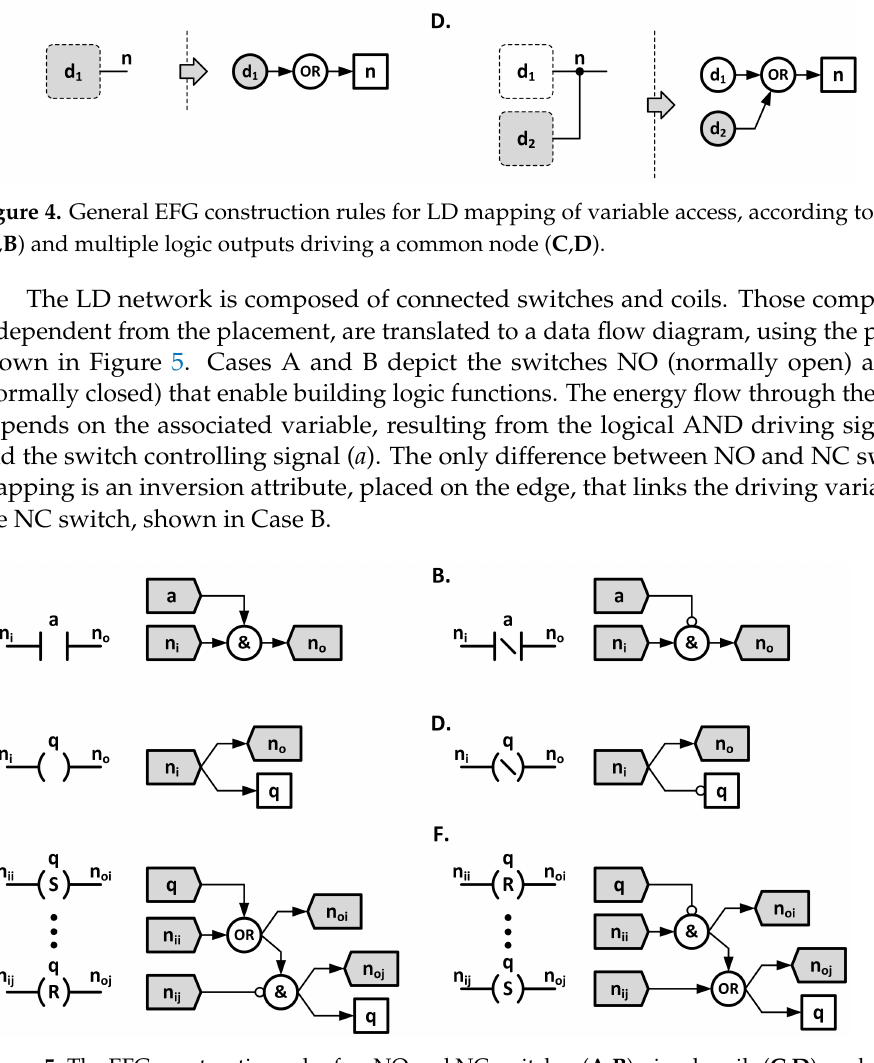
Figure 5. The EFG construction rules for: NO and NC switches ( A , B ), simple coils ( C , D ), and set–reset coils ( E , F